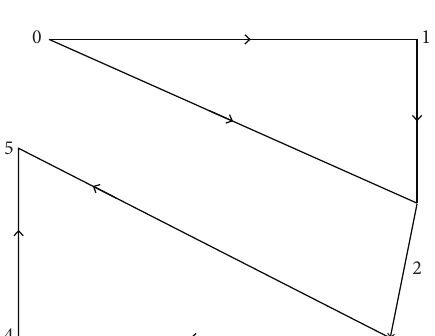
Figure 2: Two 2-dimensional surfaces.